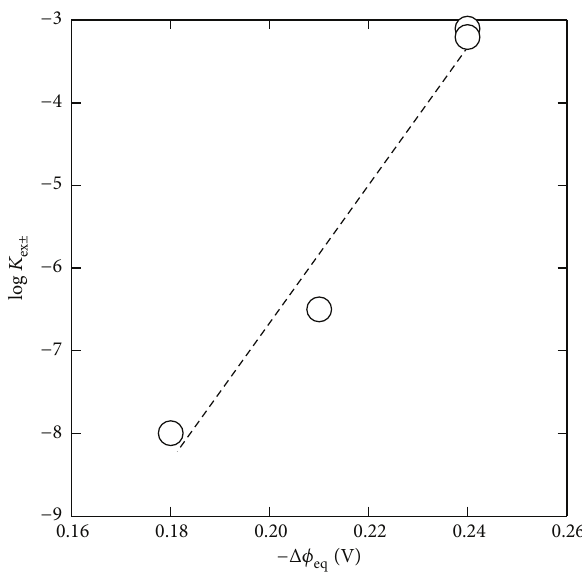
Figure 4: Plotof log 𝐾 L into Bz. See the text for the regression